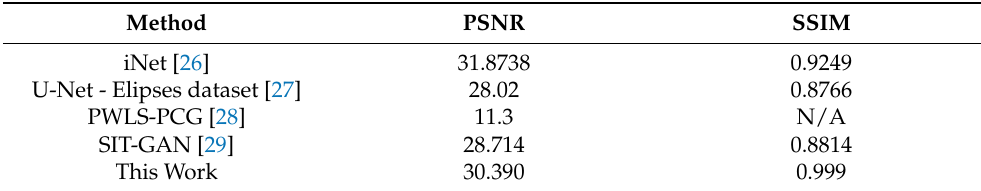
Table 1. The comparison table of results achieved with super resolution approach networks on similar